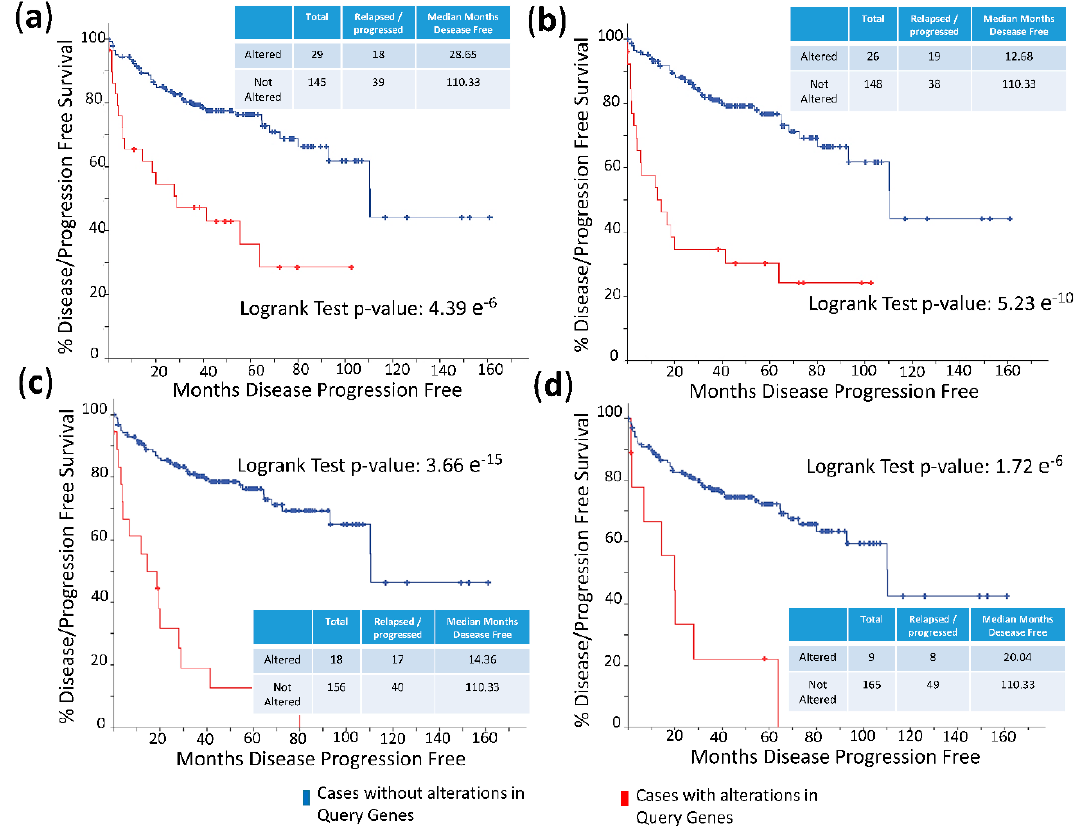
Figure 4. Disease/progression-free Kaplan–Meier estimate: ( a ) Cases altered in HMGB1 interactome targets from PC-3 library; ( b ) cases altered in HMGB1 interactome targets from prostate adenocarcinoma tissue library; ( c ) cases altered in HMGB2 interactome targets from PC-3 library; and ( d ) cases altered in HMGB2 interactome targets from prostate adenocarcinoma tissue library. Data source: prostate adenocarcinoma study [86], including 194 patients/samples.